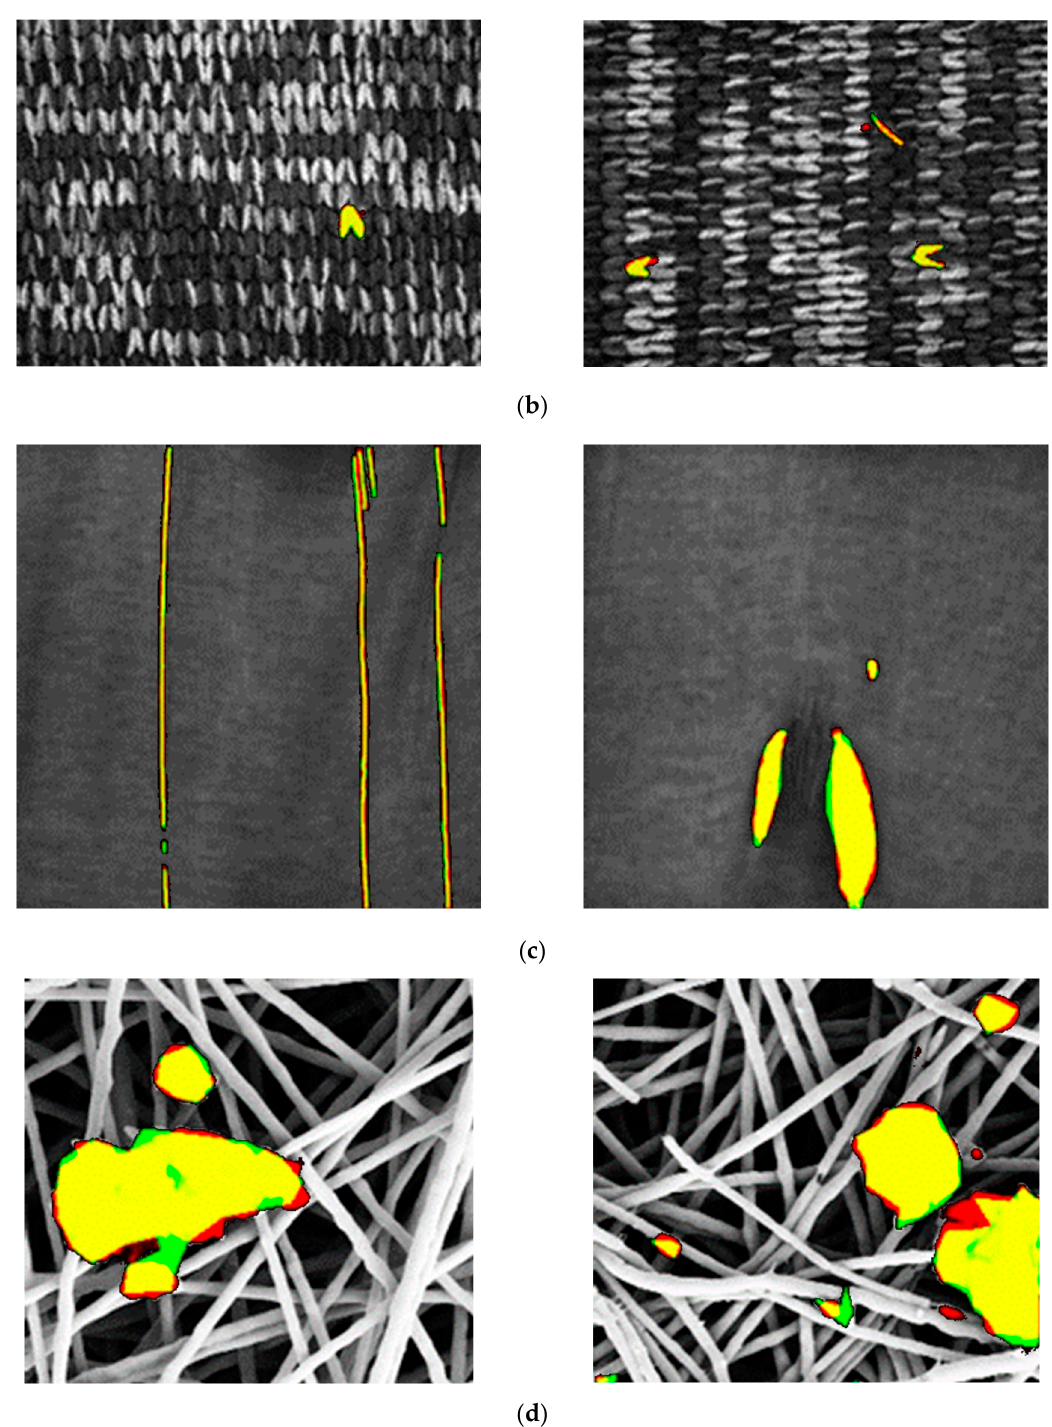
Figure 8. Object segmentation prediction result: (yellow: true positive, red: false positive, green: false negative) ( a ) Fabric A; ( b ) Fabric B; ( c ) Knitting dataset; and ( d ) Nano fiber.